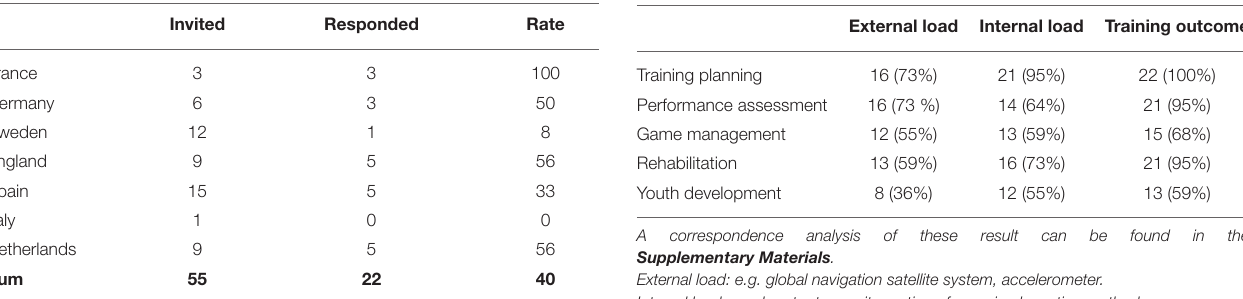
TABLE 2 | Number (proportion) of clubs that collect external load, internal load and training outcome data for the different purposes of load